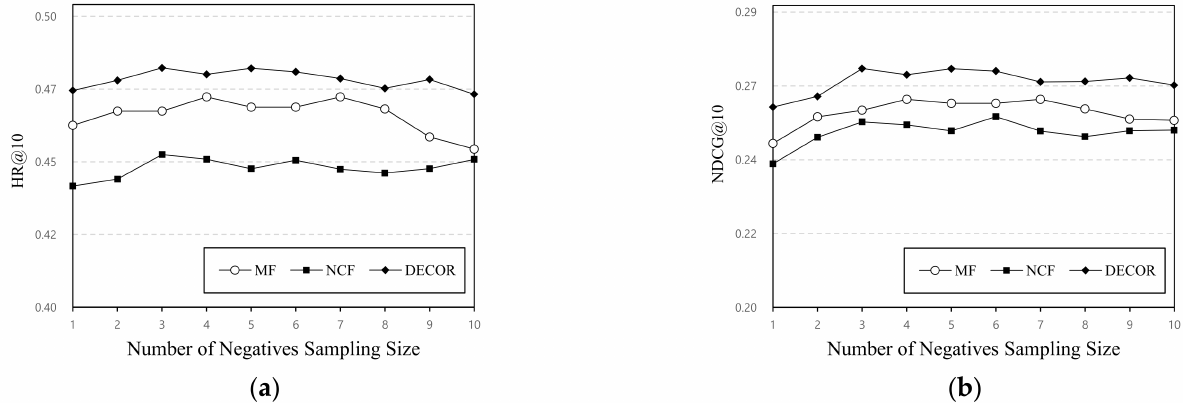
Figure 5. This figure shows the impact of a negative sampling ratio on performance: ( a ) HR@10 performance based on the number of negative sampling size; ( b ) NDCG @10 performance based on the number of negative sampling